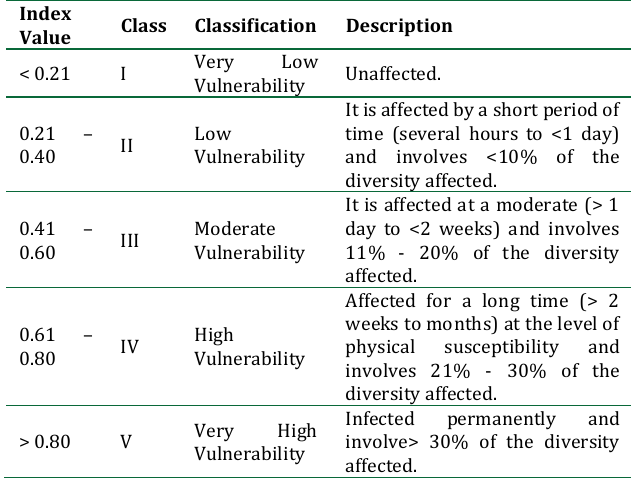
Figure 9: Environmental Vulnerability (Ve) Map Table 3: Characteristics of Environmental Vulnerability (Ve) (Rodeano,